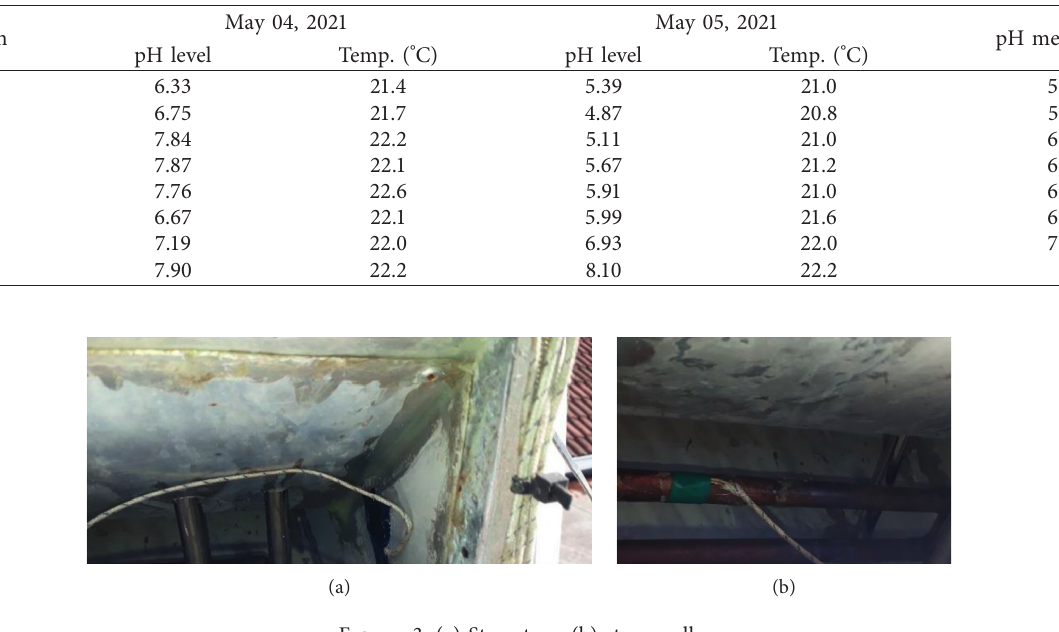
Table 2: Distillate pH results per stage of the MSS-SS.